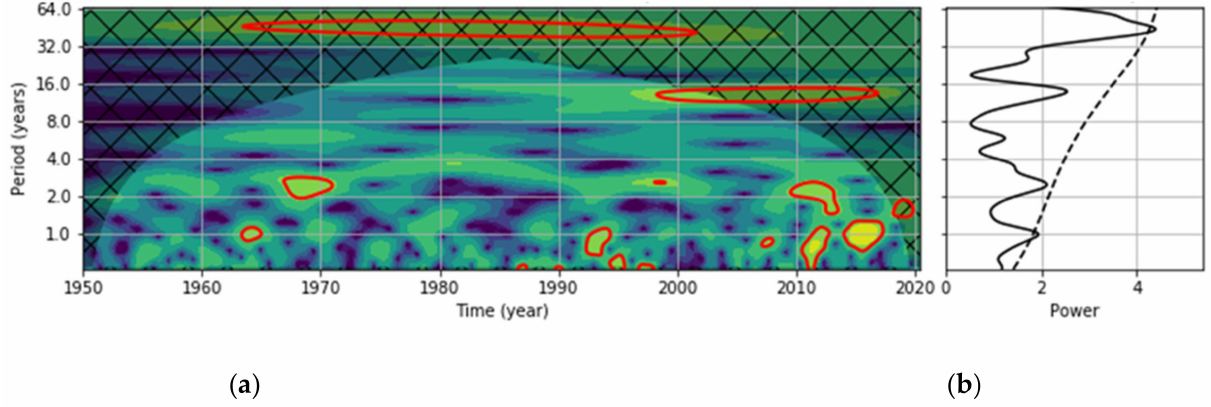
Figure 16. Results of wavelet analysis of the NAO index, illustrating the quasi-periodic behavior: ( a ) wavelet power spectrum and ( b ) global wavelet